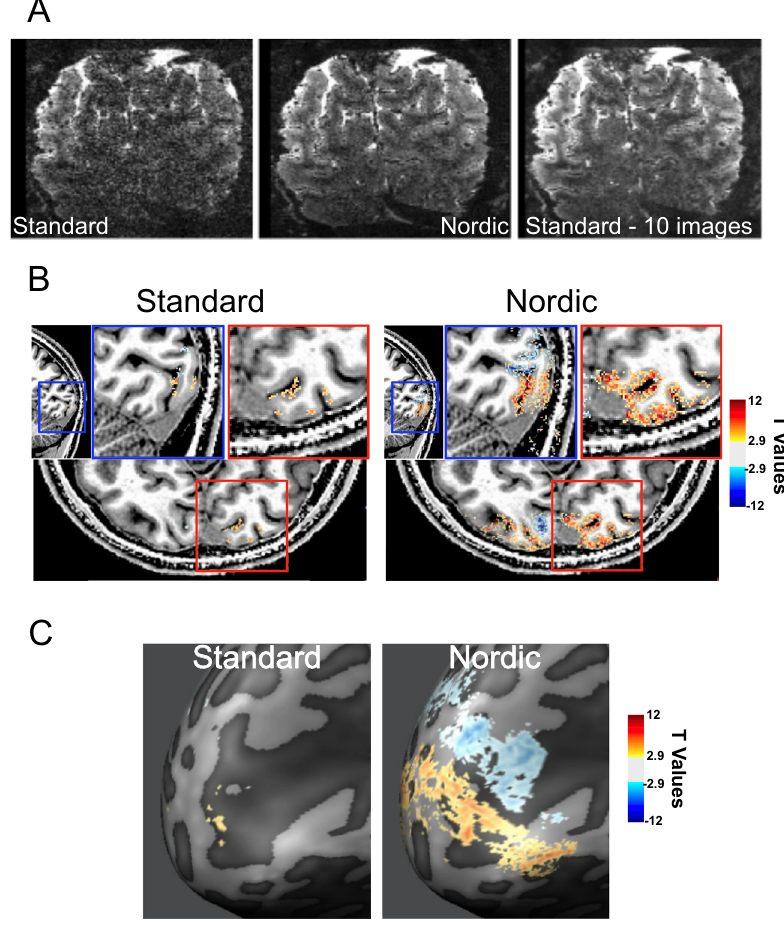
Fig. 6 3D GE EPI images and fMRI data obtained with 0.5 mm isotropic voxels. Panel A shows a single slice from a single time point in the consecutively acquired volumes forming the fMRI time series for Standard (left) and NORDIC (middle) images. The right panel shows the average of 10 images of the same slice for the Standard reconstruction. Panel B shows t -thresholded (| t | ≥ 2.9) functional maps (for the contrast target > surround on a T 1 weighted anatomical image for standard (left) and NORDIC (right) reconstructions for a saggital and axial slice (with related zoom-ins on the sagittal (blue) and axial (red) planes). Panel C shows the same t -maps as in panel C on the in fl ated cortical space and at different t -thresholds. No spatial smoothing or masking was applied to the